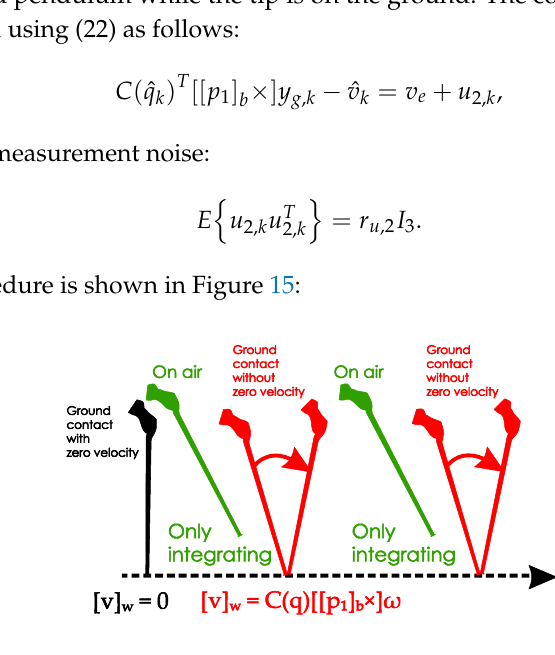
Figure 15. Velocity updating procedures for a standard